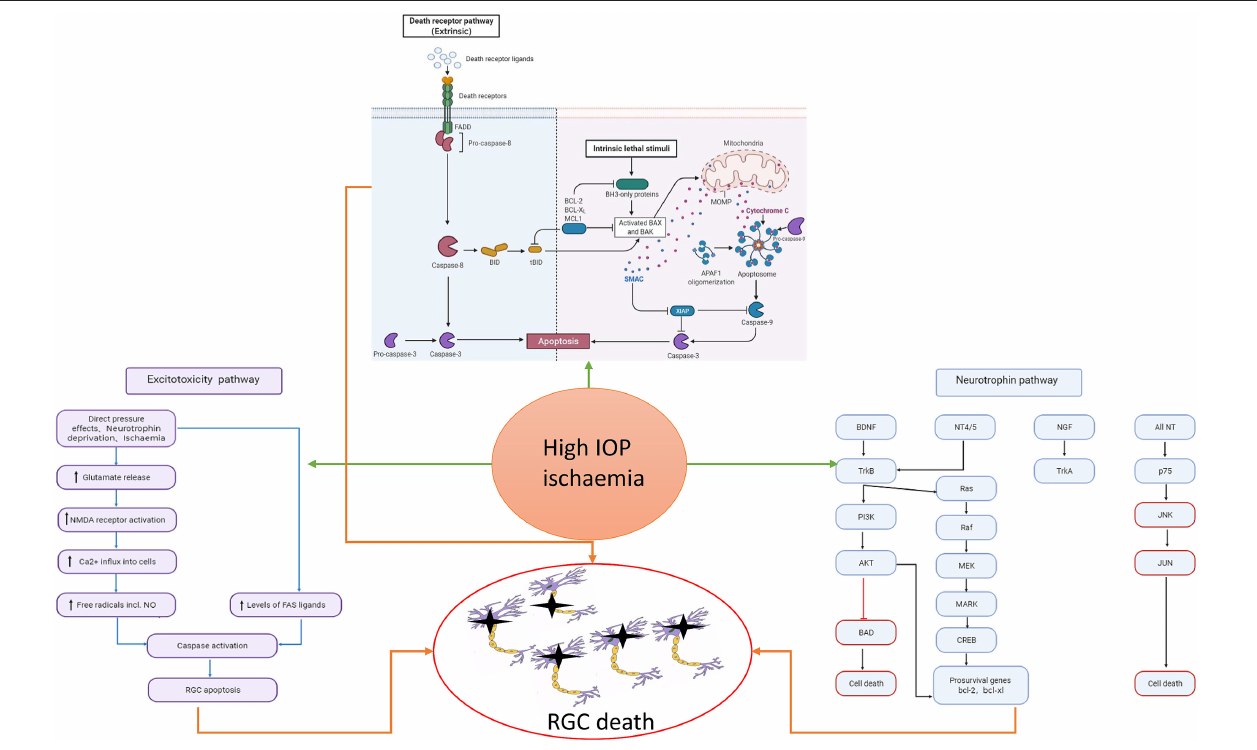
FIGURE 1 | Risk factors such as high intraocular pressure and ischemia can cause the activation of cell apoptosis, the increase of excitotoxicity, and the imbalance of neurotrophic pathway, which will eventually cause the death of RGC. In the neurotrophic pathway, blue represents the pathway through which neurotrophic factors function under normal conditions, and red represents the pathway through which RGC damage is caused by